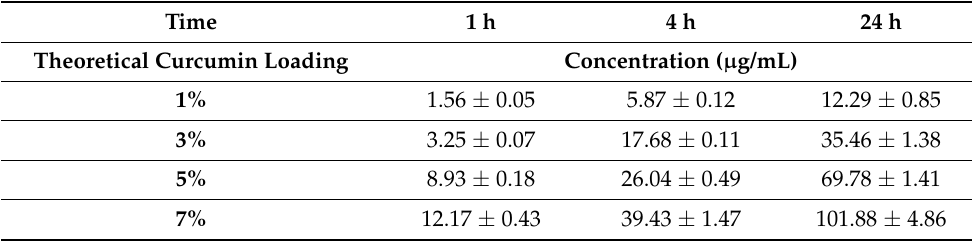
Figure 13. Cytotoxic effects of various concentrations of curcumin in serial solutions (positive control) on the U87 cell line after 48-h treatment. Results from three replicate measurements are presented as mean ± SD. Table 7. The curcumin equivalent concentrations to the cell culture media of release samples acquired in different durations (1 h, 4 h, 24 h) from 3D printed scaffolds with different loadings (1%, 3%, 5%, 7%, w / w) analysed via HPLC.